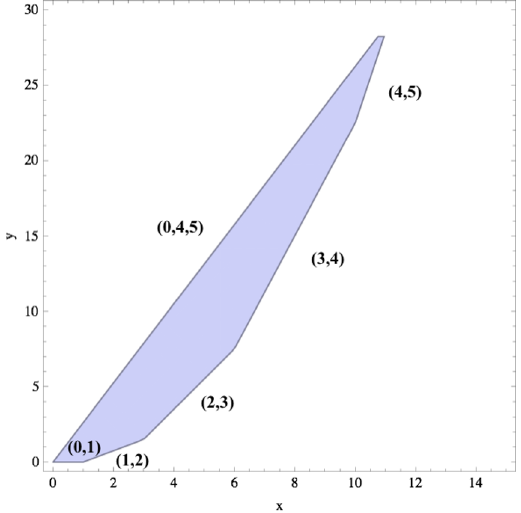
Figure 8 . The projection of the unitary polytope onto the cyclic plane at k = 5 . The boundary is given by (0 , 4 , 5) as well as ( i, i +1 , ∞ ) for i = 0 , · · · , 4 , displayed as ( i, i +1) .